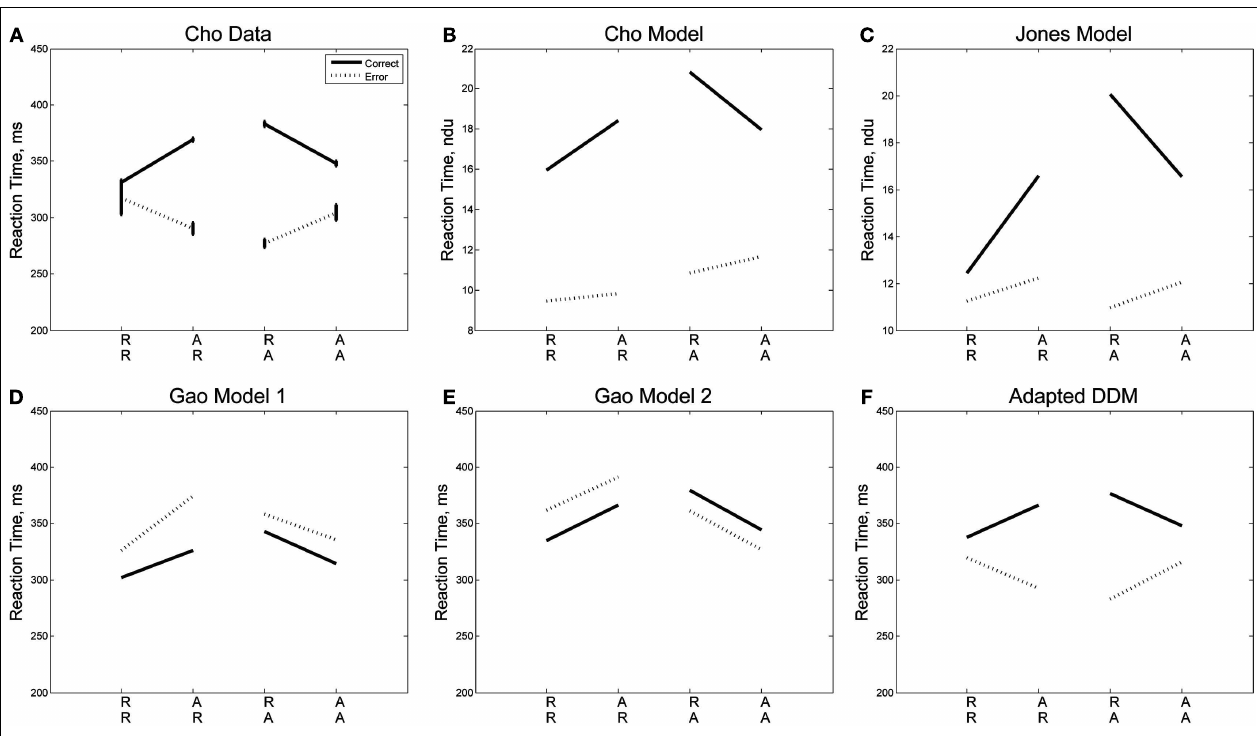
DDM captures the slopes of the R and A curves for error and correct trials. In these figures, the correctness or lack thereof of a given trial corresponds only to that trial itself, so a left-right-left sequence is tabulated as correct for the final left stimulus if and only if the final trial were identified correctly as a left stimulus.